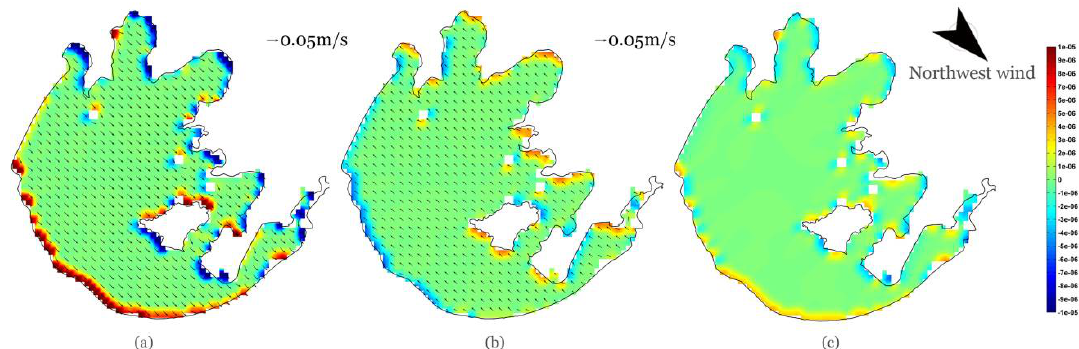
Figure 14. Numerical model results of velocity and vorticity with 2 m constant depth and constant northwest wind. The vectors represent velocity and colored patches represent vorticity. ( a ) Surface layer; ( b ) Bottom layer; ( c ) Vorticity of depth-averaged velocity.